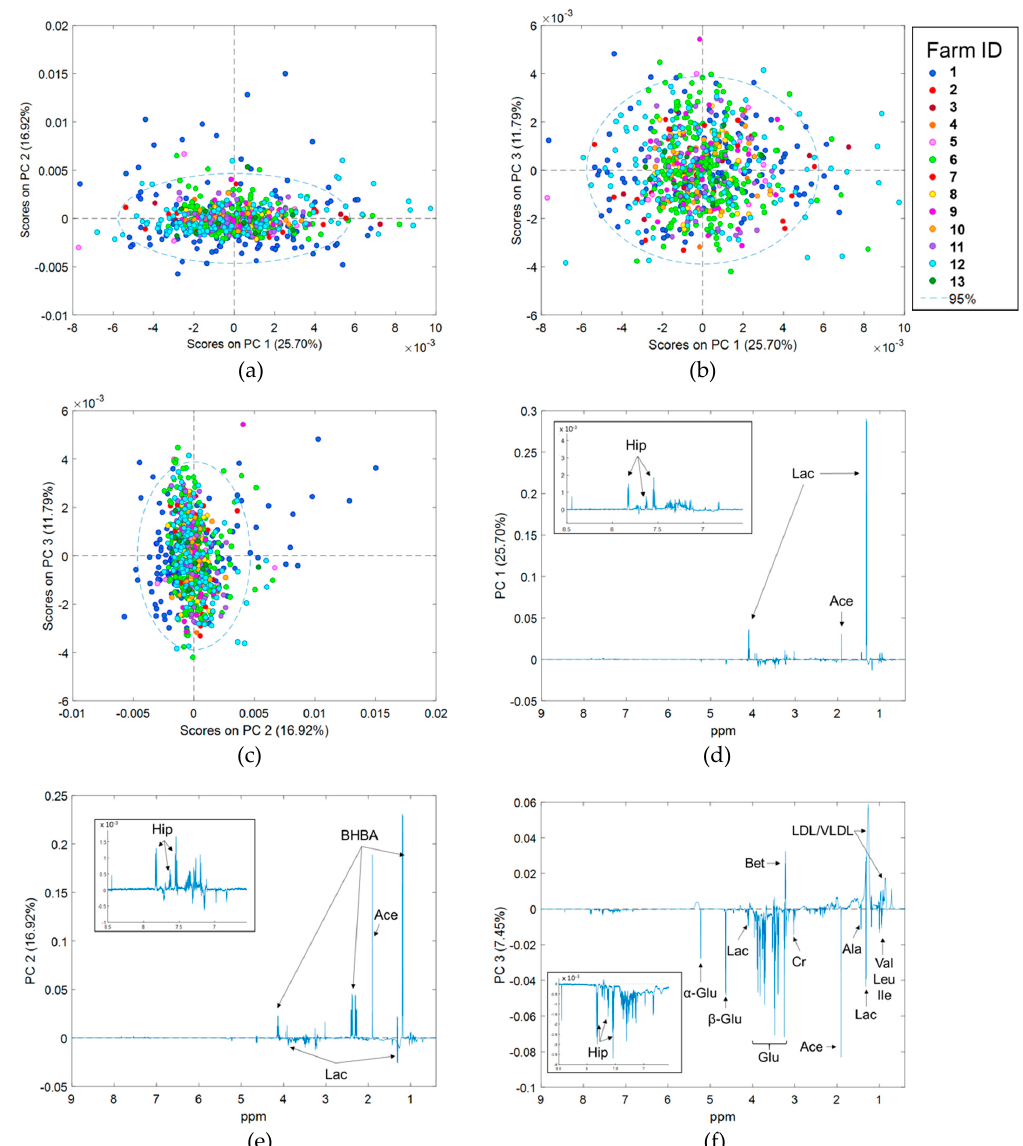
Figure 2. Results of PCA of 707 1 H NMR spectra of serum, corrected for herd of origin, week of lactation, and parity obtained from dairy cows in early lactation; ( a ) PC 1 vs. PC 2 scores, ( b ) PC 1 vs. PC 3 scores, ( c ) PC 2 vs. PC 3 scores, ( d ) PC 1 loadings, ( e ) PC 2 loadings, and ( f ) PC 3 loadings plots. Scores plots are colored by farm of origin. The δ 6.5 to 8.5 region of loadings plots have been magnified for clarity purposes. α -Glu = α glucose, Ace = acetate, Ala = alanine, β -Glu = β glucose, Bet = betaine, BHBA = β hydroxybutyrate, Cr = creatine, Glu = glucose, Gly = glycine, Ile = isoleucine, Lac = lactate, Leu = leucine, Val = valine, VLDL / LDL = Very low density lipoprotein and low density